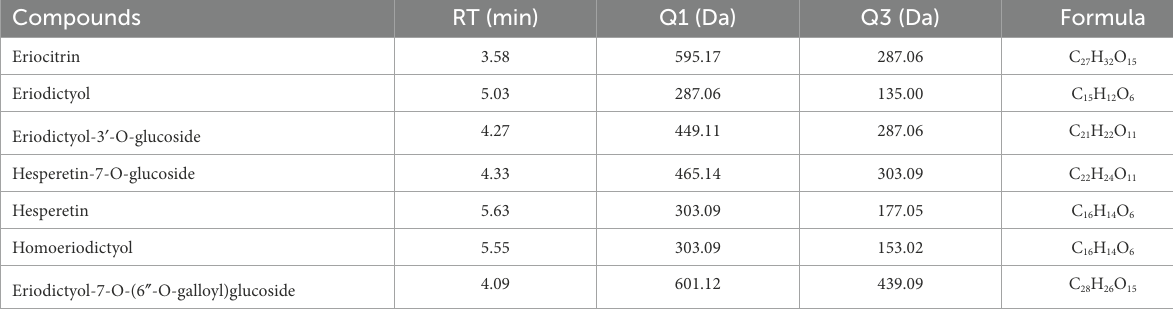
TABLE 1 Eriocitrin metabolites in mice colonic contents.